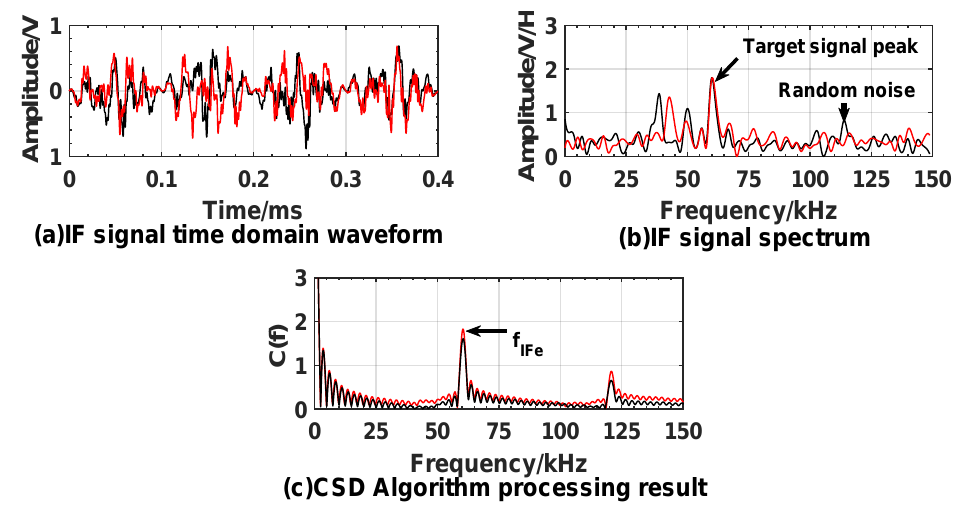
Figure 14. Experiment results when expected distance is 9 m under smoke interference. Figure layout is the same as Figure 13. Each simulation result includes two detections, the red curve represents the first detection, and the black curve represents the second